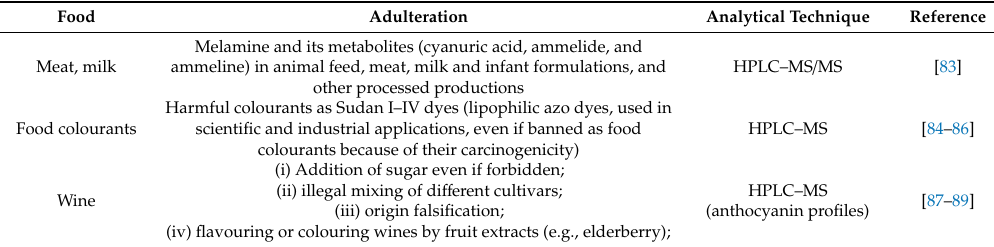
Table 2. Cases of food adulterations solved by the application of mass spectrometry coupled to chromatographic